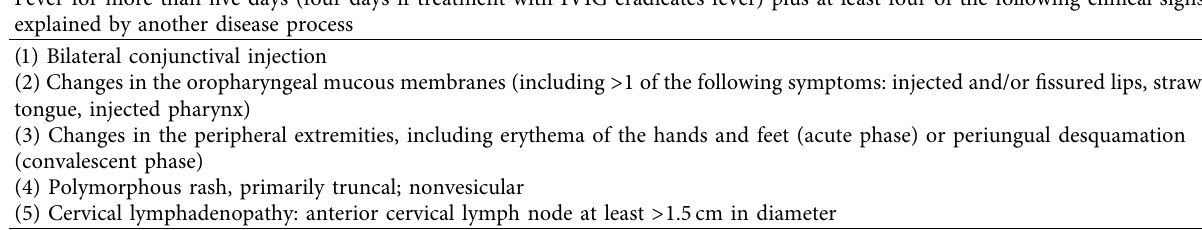
Table 1: Criteria for the diagnosis of Kawasaki